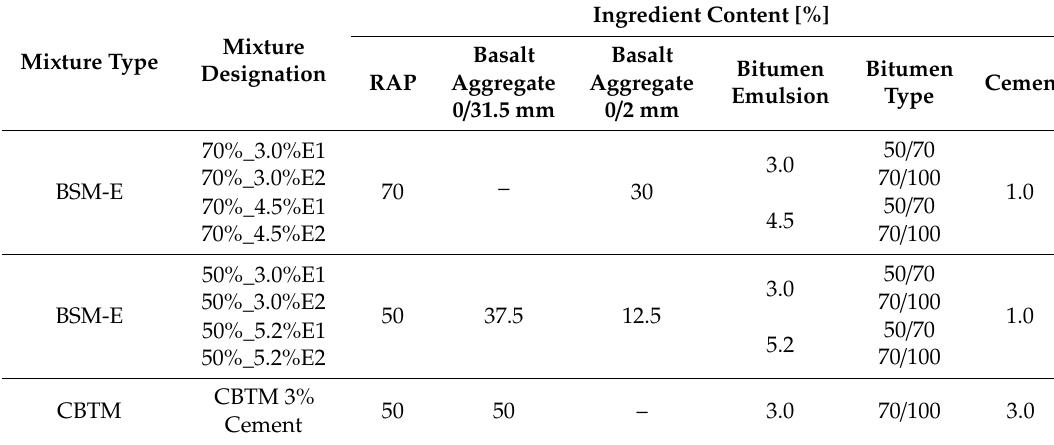
Table 1. BSM-E and CBTM mixture